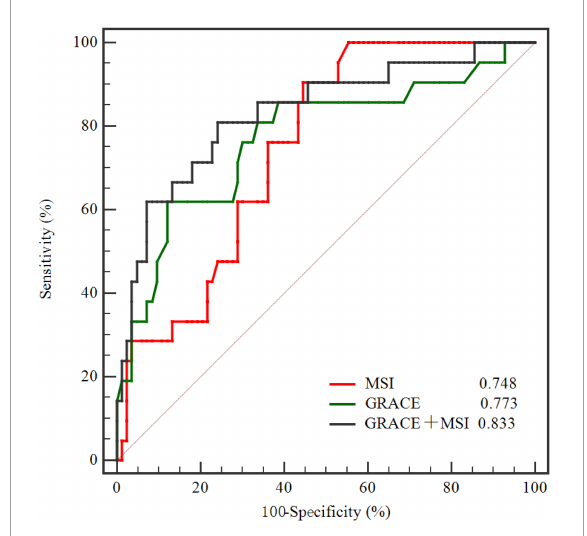
FIGURE4 Comparison of ROC curves demonstrating discrimination of the MSI, GRACE, and GRACE + MSI in predicting MACE. MSI, myocardial salvage index; GRACE, Global Registry of Acute Coronary Events; ROC, receiver operating characteristic; MACE, major adverse cardiac events.